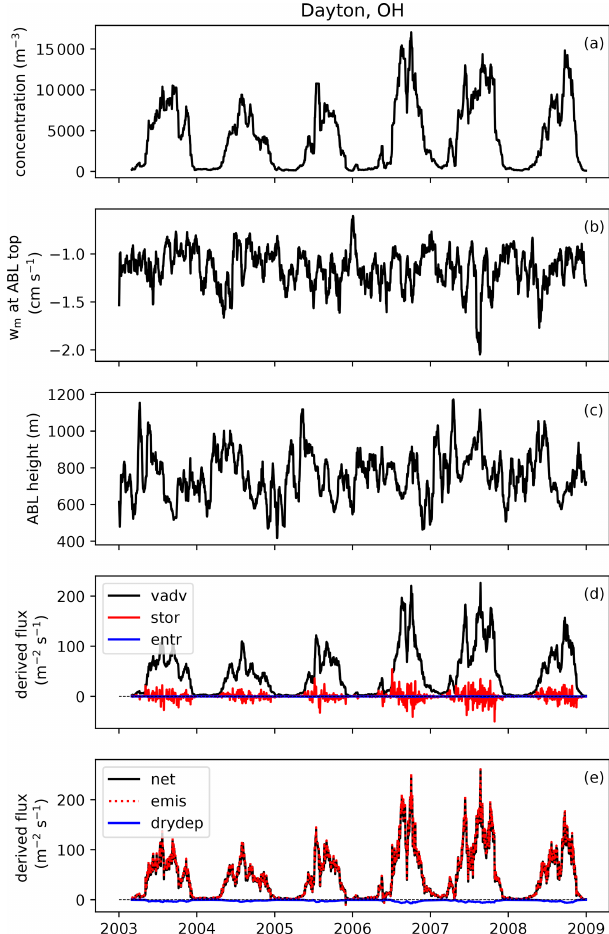
Figure 2. Example of how emissions flux is derived from ob- served concentrations at one AAAAI site located in Dayton, OH. Shown here are 20d running mean time series of (a) fungal spore concentration; (b) subsidence velocity at atmospheric boundary layer (ABL) top; (c) mean height of the afternoon boundary layer; (d) contributions of vertical advection (vadv), storage (stor) and en- trainment (entr) terms to the calculated flux; and (e) calculated net flux, emission flux and dry deposition